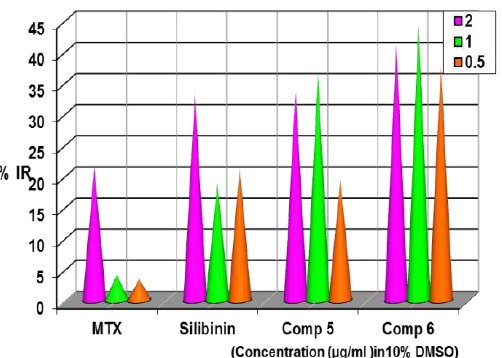
Figure(1):The cytotoxic activity represented by inhibition rate percent of compounds MTX,silibinin,compound 5,6 at different concentrations (0.5 ,1,2) μg/ml in 24 hrs time of exposure .